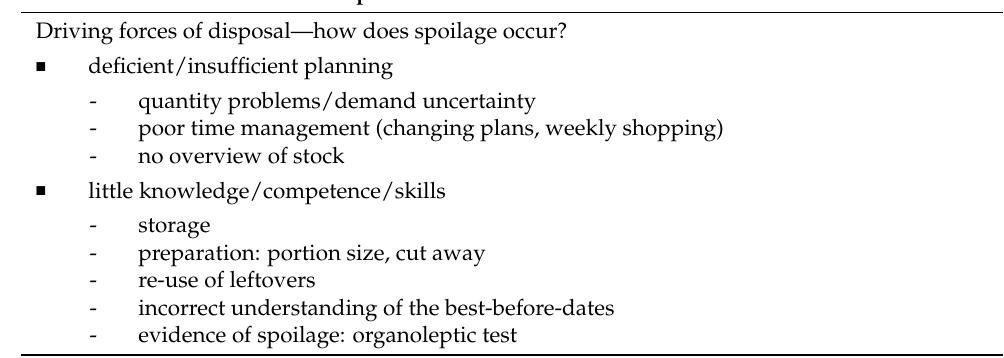
Disposal Of Food At Consumer